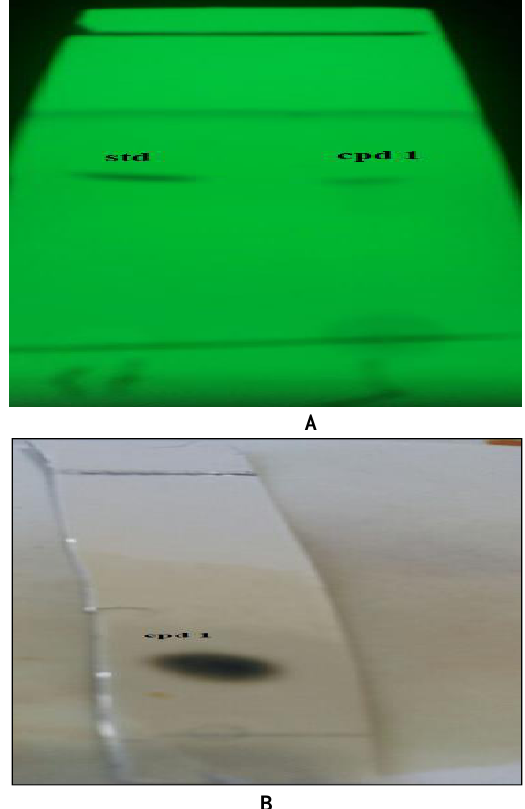
Figure 5. TLC chromatography (A) for separated compound number (1) from ethyl acetate fraction and Rosmarinic acid STD using silica gel Gf254 as adsorbant and S1 as mobile phase and (B) separated compound after detected by spraying with five %ferric chlorides.